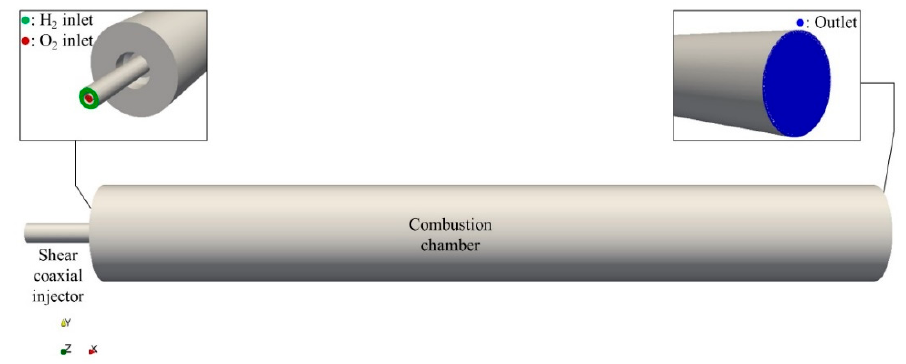
Figure 1. Computational domain of RCM-3 combustor with two inlets and one outlet. Table 2. Propellant supply conditions for RCM-3 C60 case.